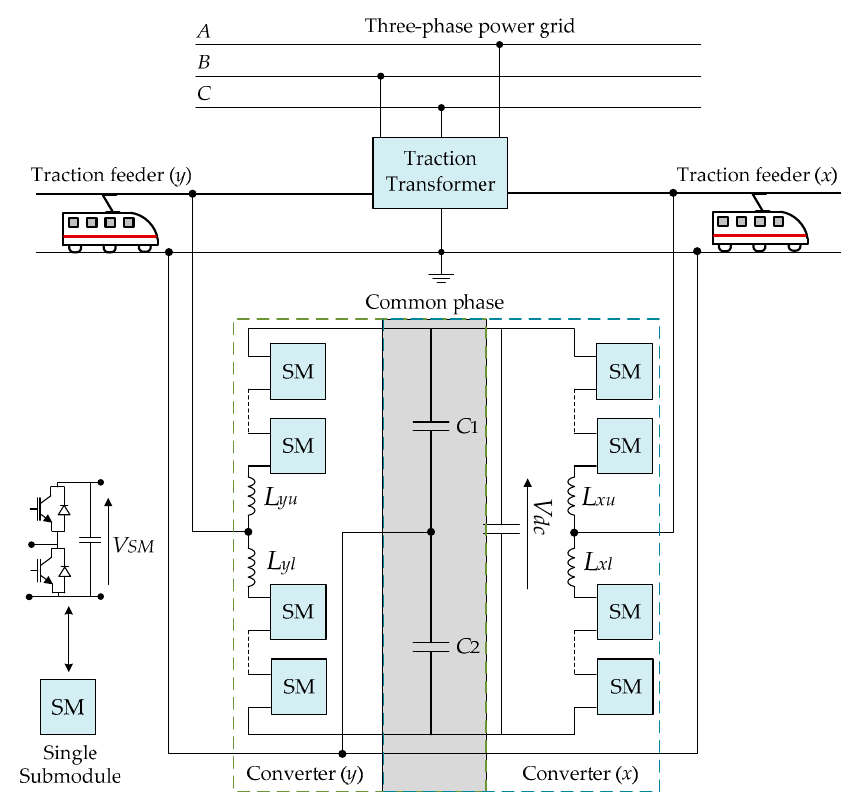
Table 12. Components quantities of the HB-MMC2 RPC.